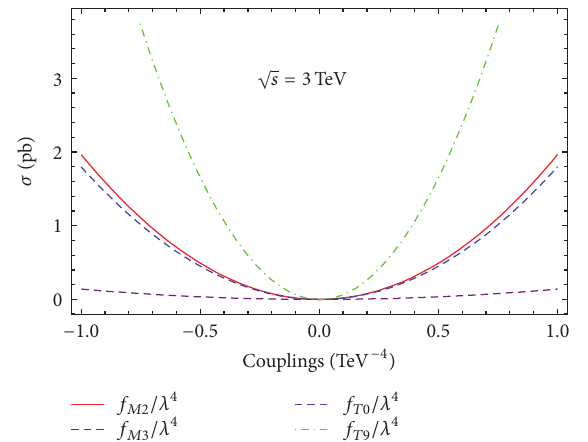
Figure 4: The total cross sections as function of anomalous 𝑓 𝑀2 /Λ 4 , /Λ 4 , 𝑓 /Λ 4 , and 𝑓 /Λ 4 couplings for the process 𝑒 − 𝛾 → 𝑓 𝑀3 𝑇0 𝑇9 𝑒 − 𝛾 ∗ 𝛾 → 𝑒 − 𝑍𝑍 at CLIC with √𝑠 = 3 TeV.